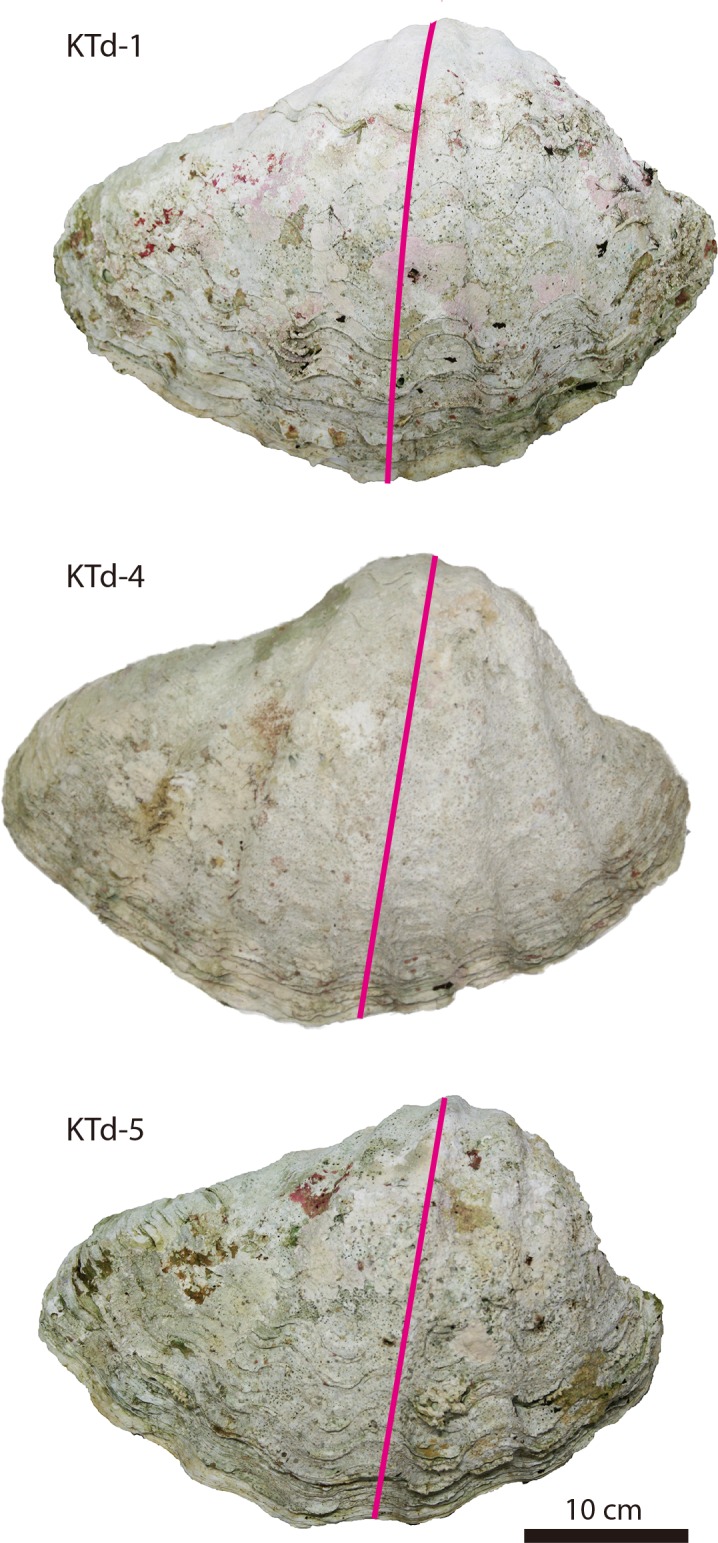
Photographs of the studied Tridacna derasa shells.The shells (left valves) were cut vertically (pink lines) along their maximum growth axes.